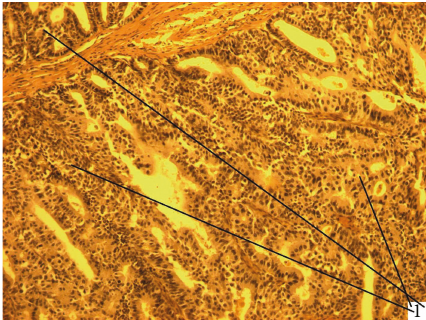
Figure 6: Experimental cholangiocarcinoma with a tender stroma in the setting of SO. HE staining, magni fi cation 200x (1: adenocarcinoma).